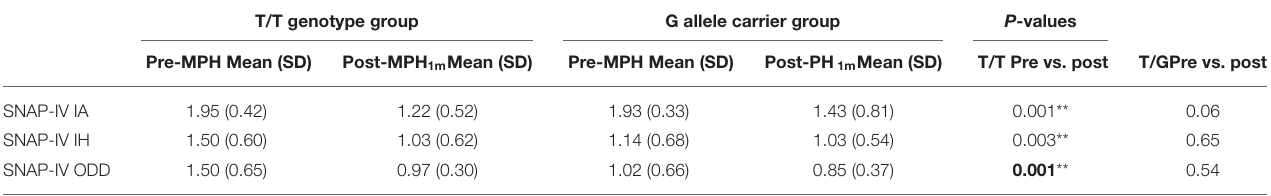
TABLE 4 | Differences in clinical outcomes between pre- and post-MPH treatment